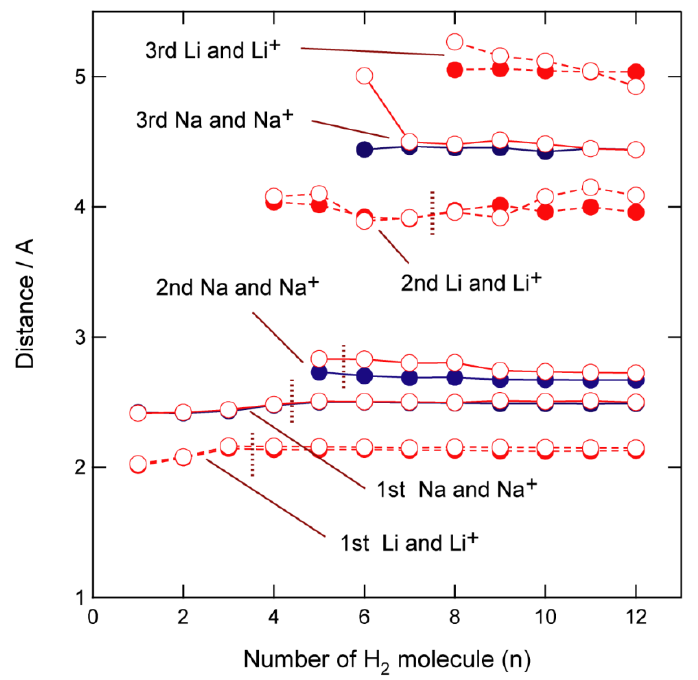
Figure 3. CAM-B3LYP/6-311G(d,p)-calculated M – H interatomic distances in GR-M-(H 2 ) n ( n = 1 – 12, M = Li, Li + , Na, and Na + ) as functions of the number of H 2 molecules ( n